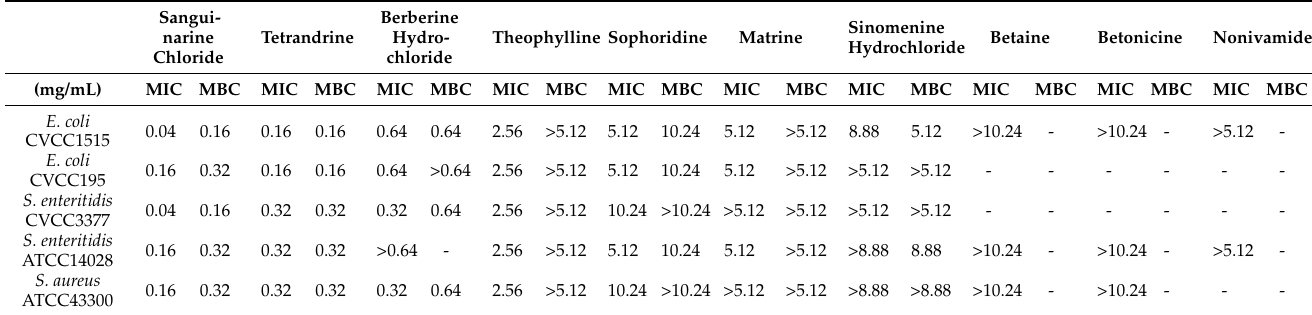
Table 1. MIC and MBC values of alkaloids against different bacterial